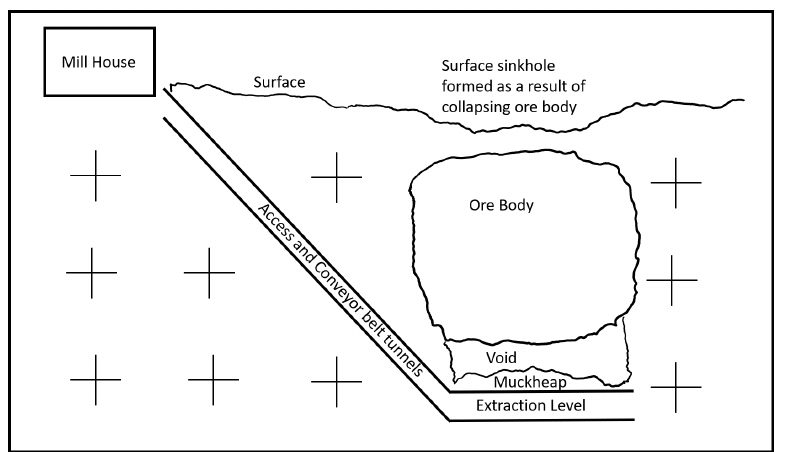
Figure 1. Block cave mine.